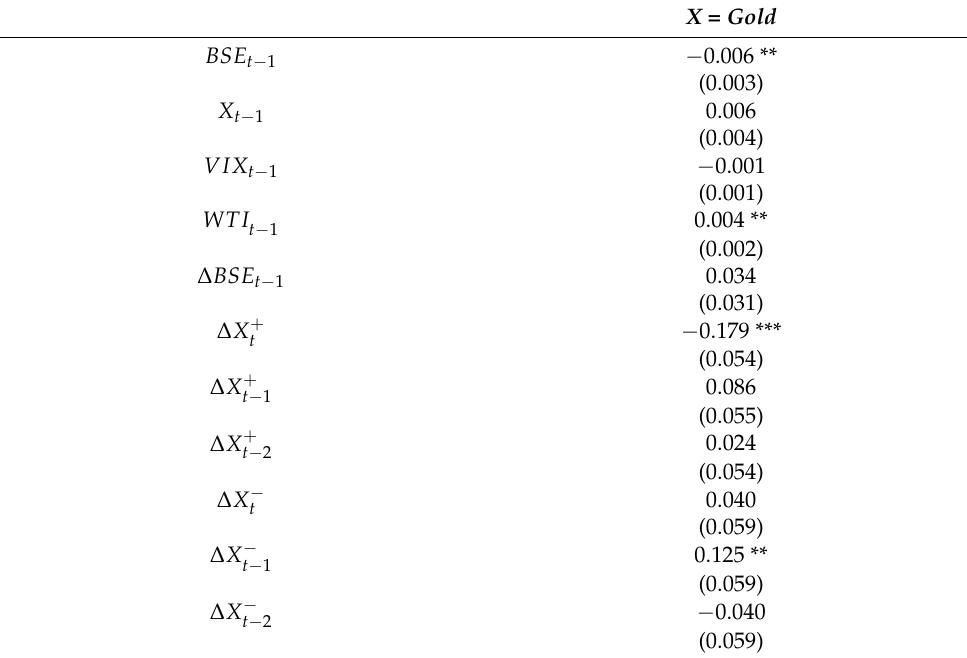
Table 5. Estimation results for BSE before